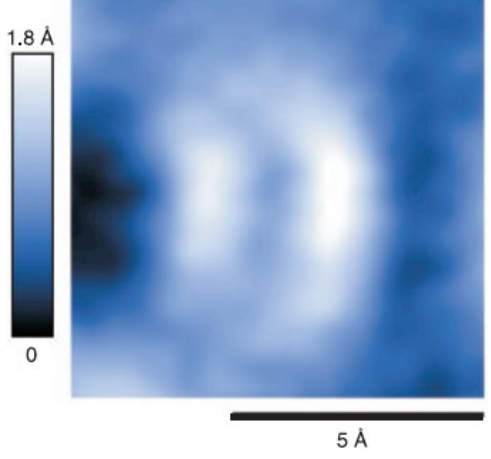
Figure 21. Topographic AFM data of a single adatom in Si(111)–(7 × 7) recorded with a room temper- ature UHV AFM fitted with a qPlus sensor with a tungsten tip, presumably terminated by a silicon cluster that points in a [001] direction exposing two dangling bonds. Adapted with permission by American Association for the Advancement of Science from Figure 3 in